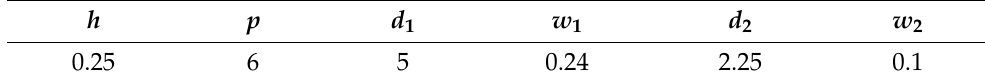
Table 1. Structure parameters of the dual band-stop FSS (unit: